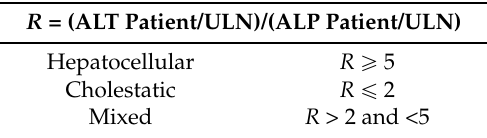
Table 1. Drug-induced liver injury (DILI) pattern of